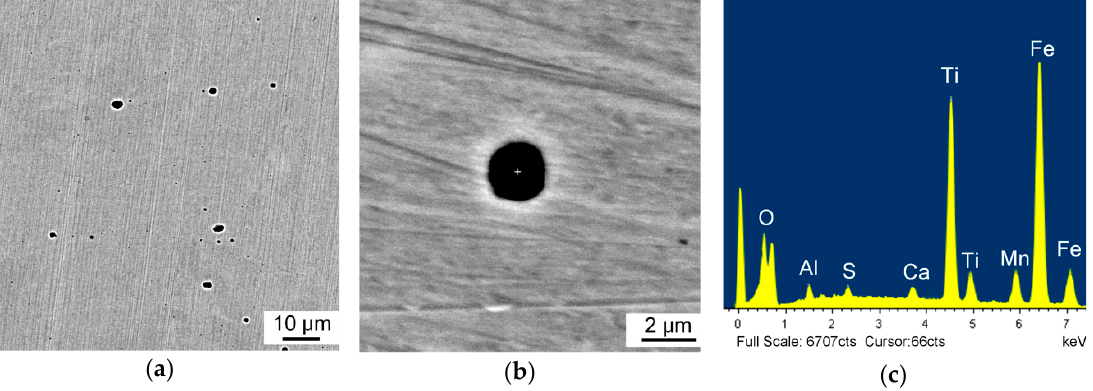
Figure 2. ( a ) An example of electron probe microanalyzer (EPMA) micrographs used for inclusion statistics; ( b ) EPMA micrograph at higher magnification; ( c ) energy dispersive spectroscopy (EDS) analysis of typical inclusion in TC# steel.